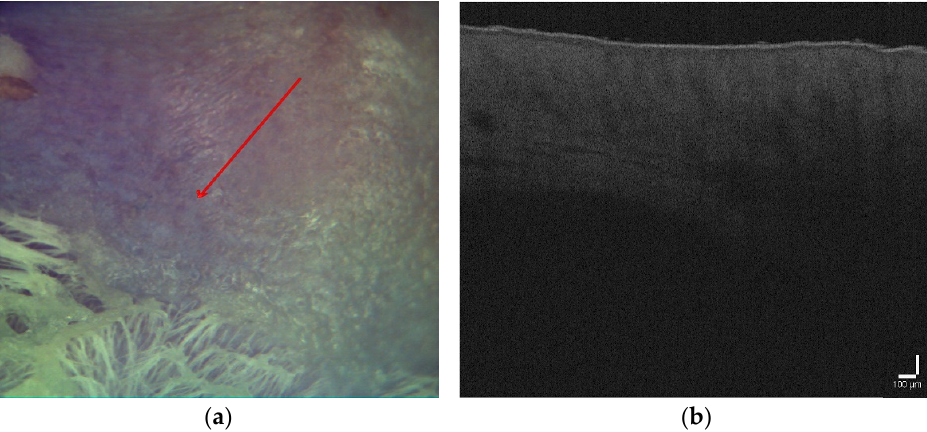
Figure 3. ( a ) Visual observation for healthy skin, ( b ) OCT imaging.